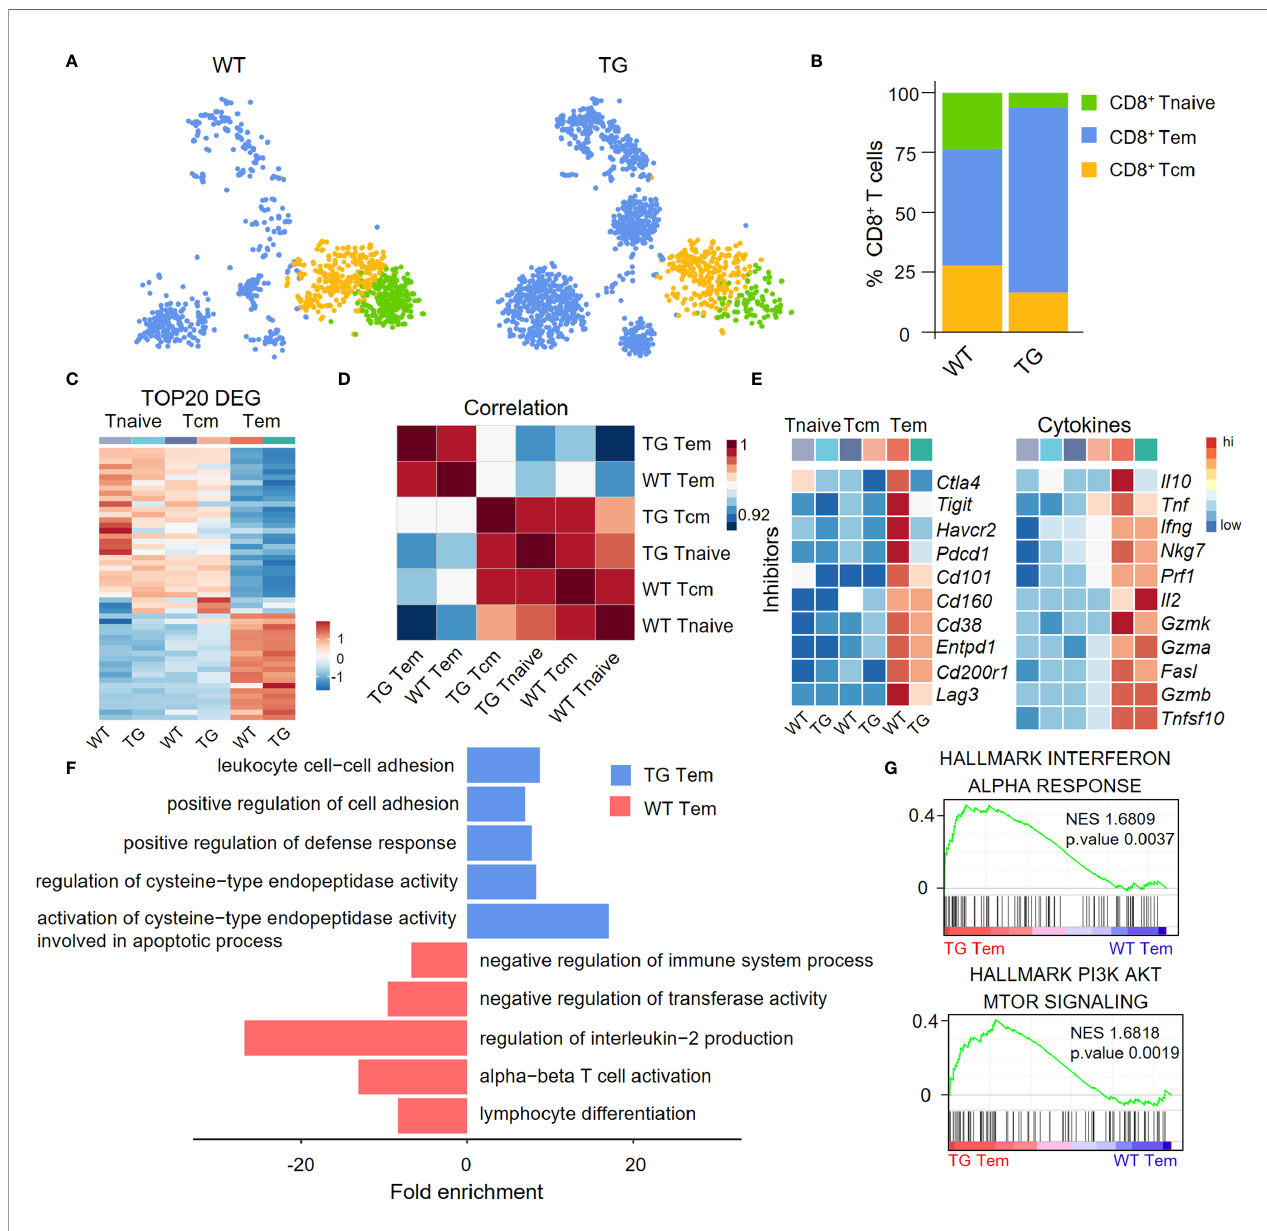
FIGURE 3 | Characterization of liver CD8 + Tem cells in TG mice. (A) CD8 + T cell subpopulations from WT and TG mice, including naïve CD8 + T cells, central memory CD8 + T cells and effector memory CD8 + T cells, shown with split t-SNE plots. (B) Percentage of CD8 + T subpopulations of WT and TG mice. (C) Scaled average expression of the top 20 upregulated differentially expressed genes for each CD8 + T subpopulations. Individual cells are represented on the horizontal axis and grouped by cluster. (D) The correlation analysis of average gene expression among CD8 + T subpopulation of WT and TG mice. (E) Scaled average expression of inhibitory checkpoint molecules and cytokines by CD8 + T subpopulations from WT and TG mice. (F) GO analysis of the upregulated genes in effector memory CD8 + T cells of WT and TG mice. (G) GSEA analysis of Interferon- a response and PI3K-AKT-mTOR signaling for effector memory CD8 + T cells between TG and WT mice. The normalized enrichment score (NES), original p value and FDR adjusted p values (q.value) are